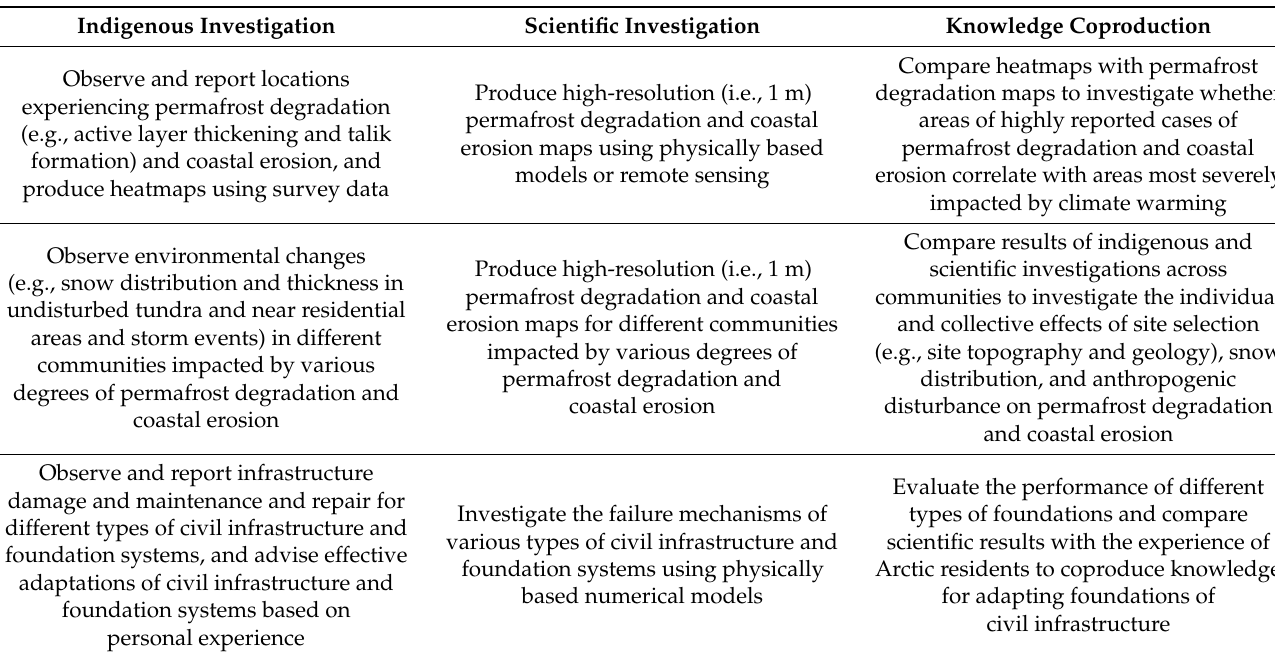
Table 8. Recommendations for future knowledge